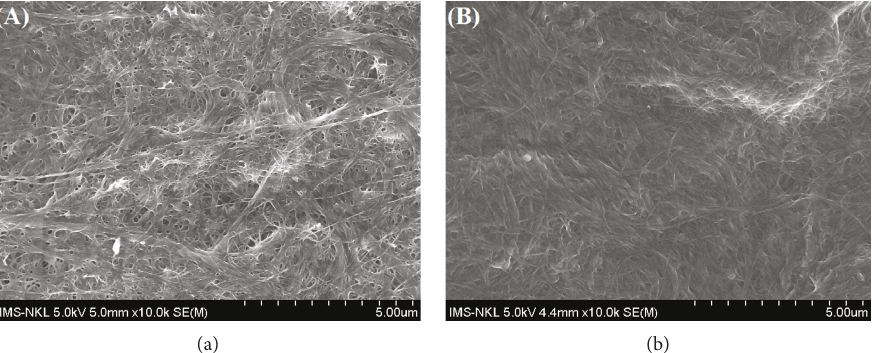
Figure 4: Scanning electron microscopy images of bacterial cellulose treated by sonication for 90 min (a) and 60min (b), at magnification x10.0